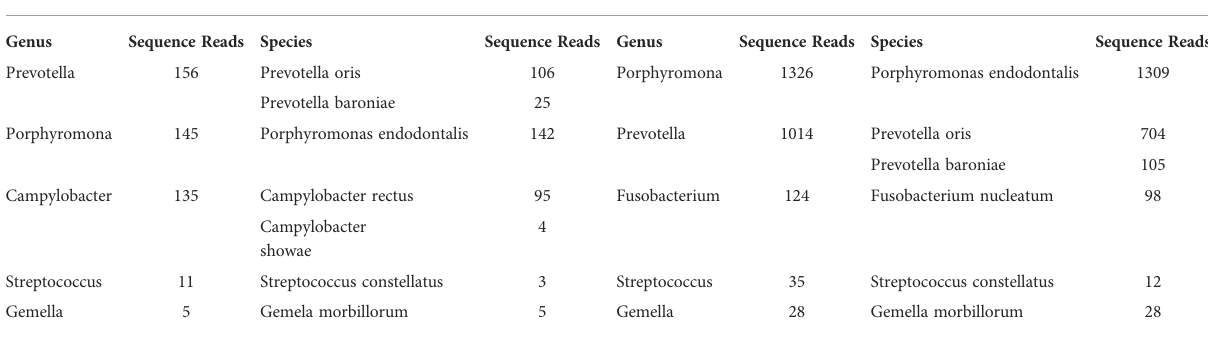
TABLE 2 The Results of mNGS in Blood and